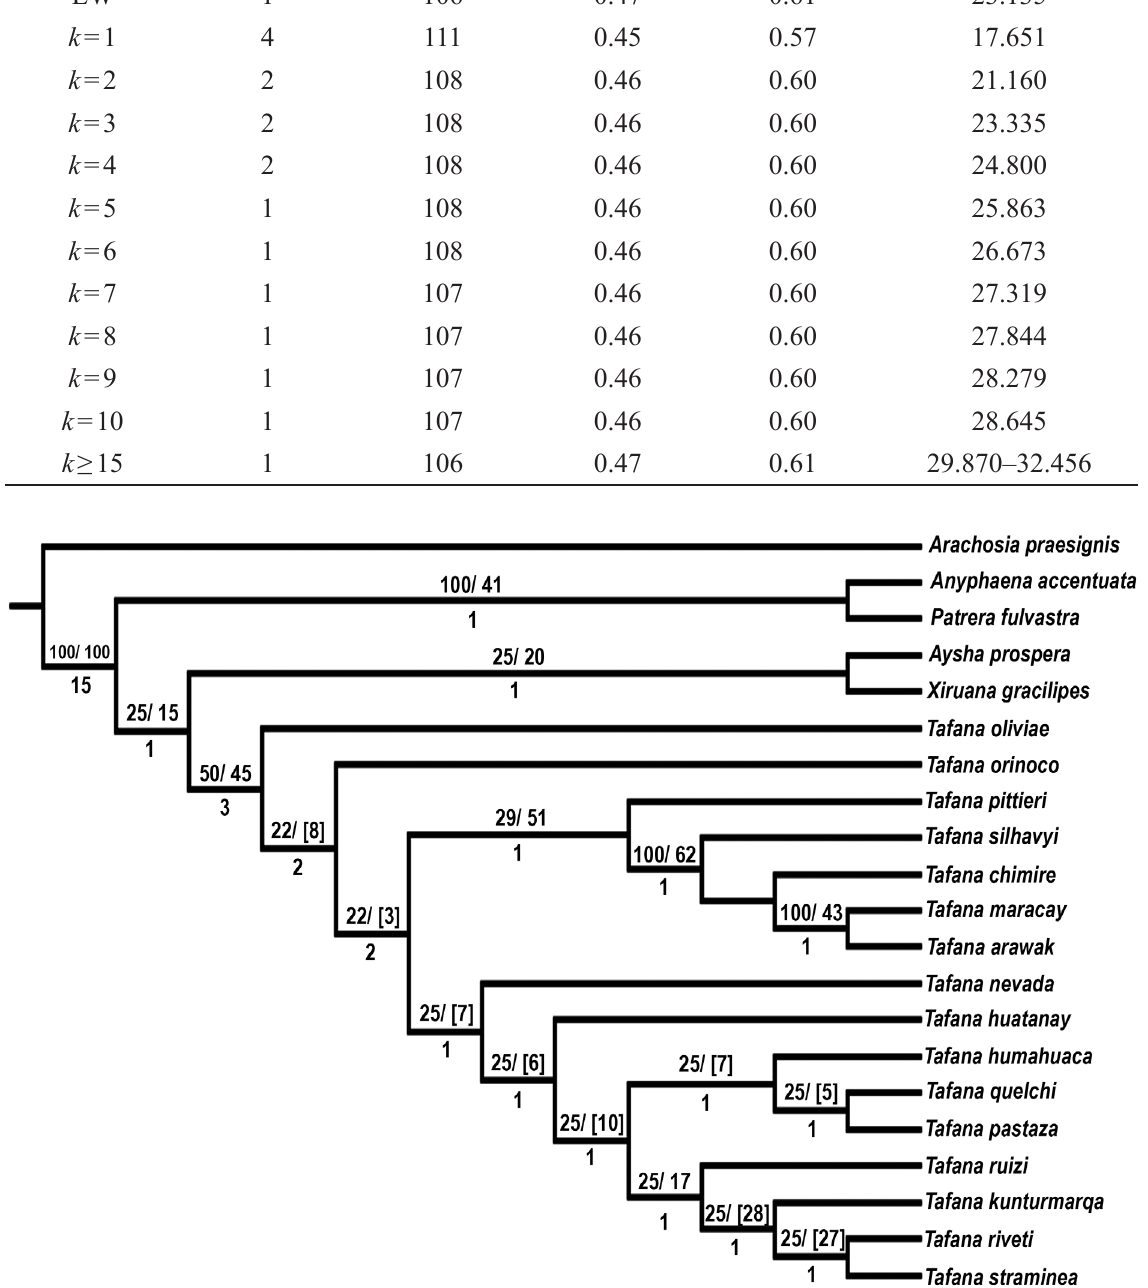
Fig. 1. The most parsimonious tree recovered under equal weights (106 steps, CI = 0.47, RI = 0.61). Numbers above branches are relative Goodman-Bremer support values (left) and Symmetric resampling values (right). Numbers below branches are Goodman-Bremer